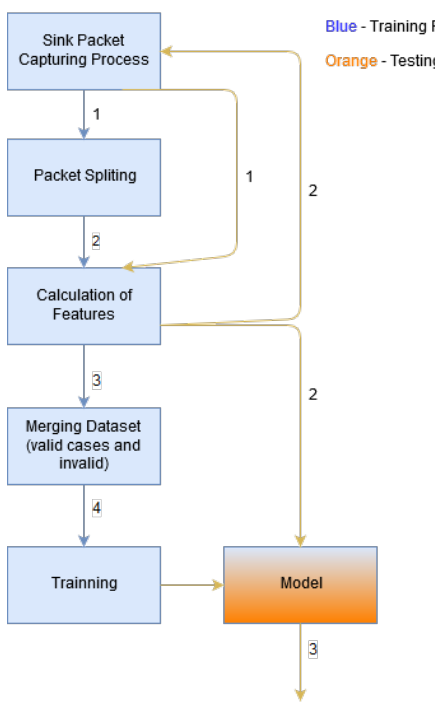
Figure 2. Approach considered for the Learning